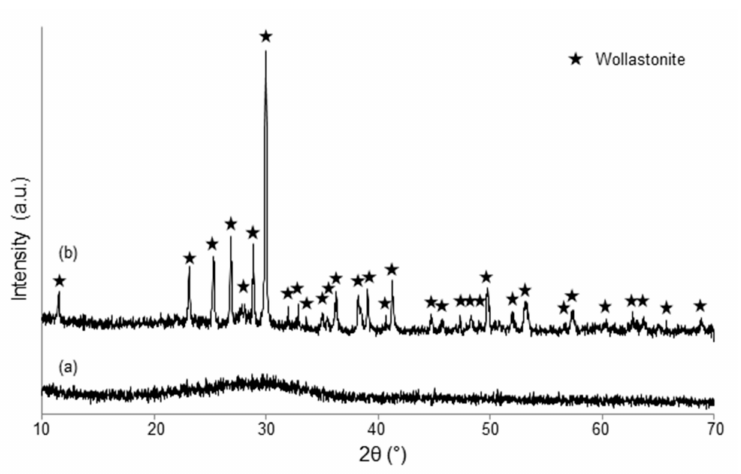
Figure 2. Wide-angle XRD pattern of ( a ) as-quenched SCNA-2Cu and ( b ) SCNA-2Cu thermally treated at 1000 ◦ C for 3